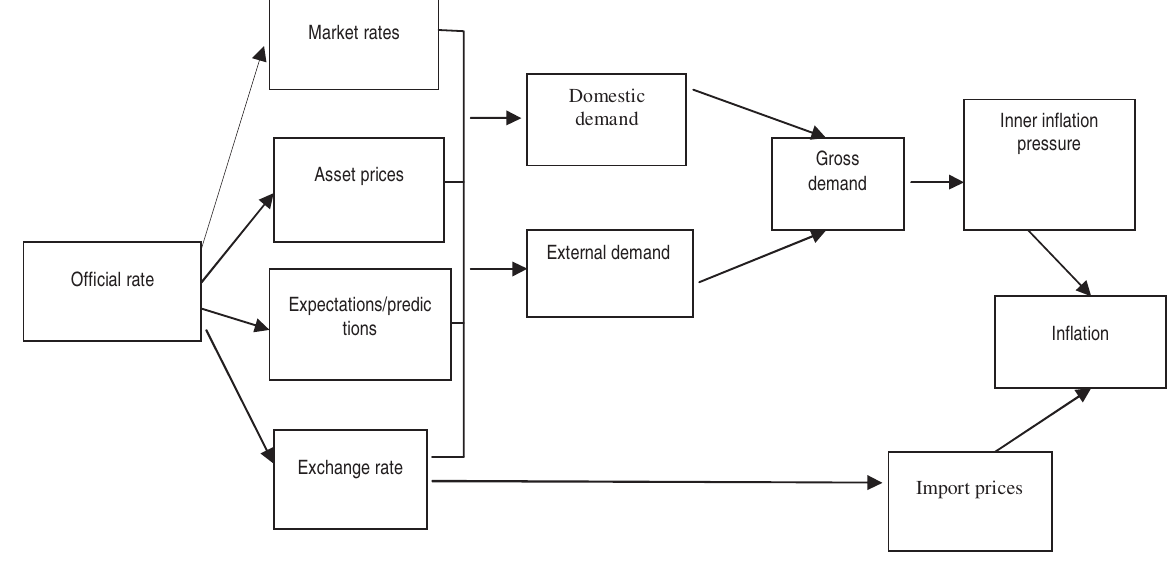
Fig. 1. Monetary policy transmission mechanism of the bank of